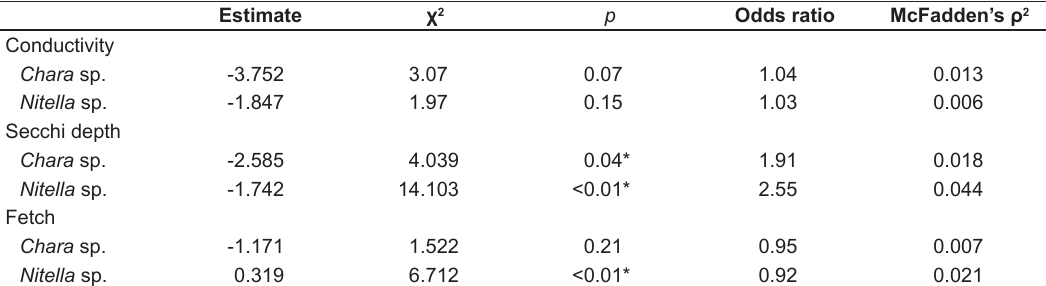
Figure 3. Frequency of occurrence of Chara sp. and Nitella sp. in each tributary of the Itaipu reservoir. AG = Arroio Guaçu; SFV = São Francisco Verdadeiro; SFF = São Francisco Falso; SV = São Vicente; SJ = São João; OC = Ocoí; RP = Rio Pinto; PC = Passo Cuê. Table 1. Results of the logistic regression using the presence of Chara sp. and Nitella sp. as dependent variables and conductivity, Secchi disk and fetch (km) as